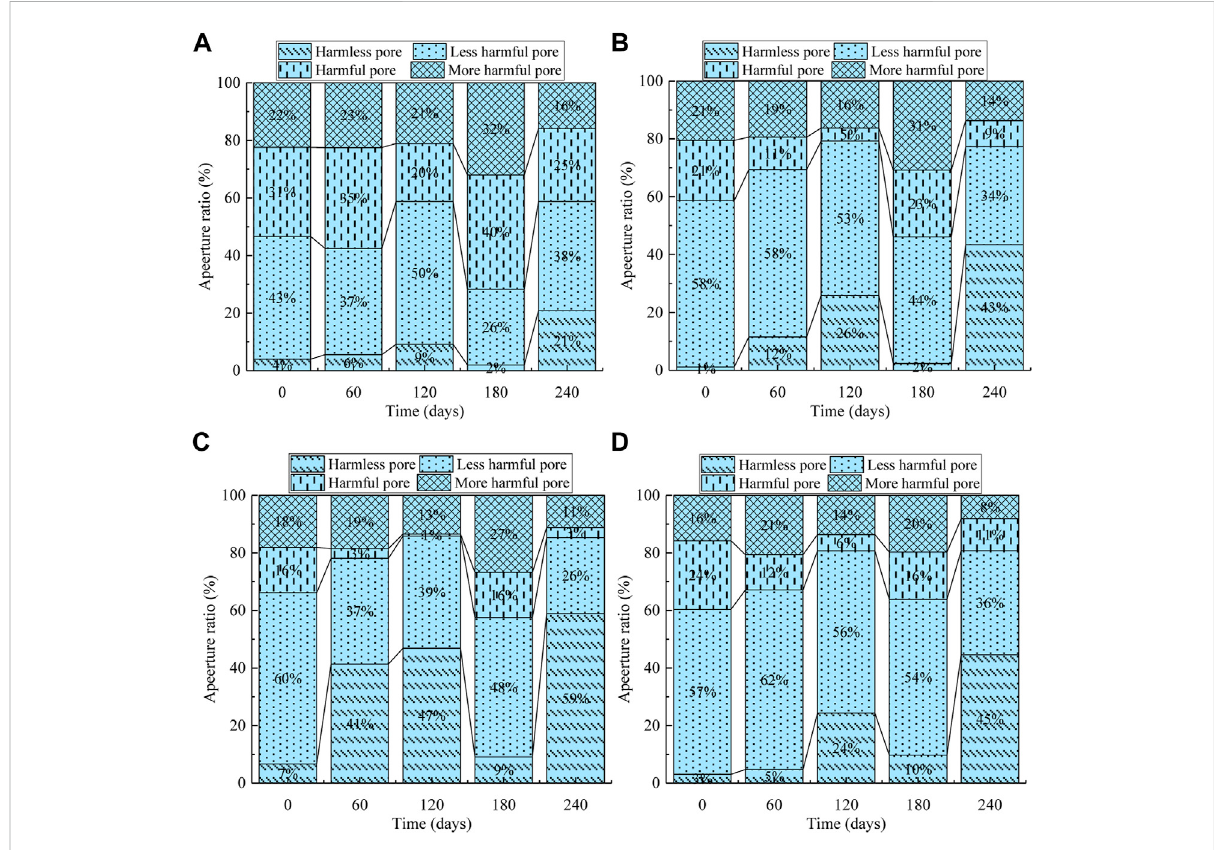
FIGURE 8 Aperture type of concrete at different erosion times; (A) GSa; (B) GSb; (C) GSc; (D)